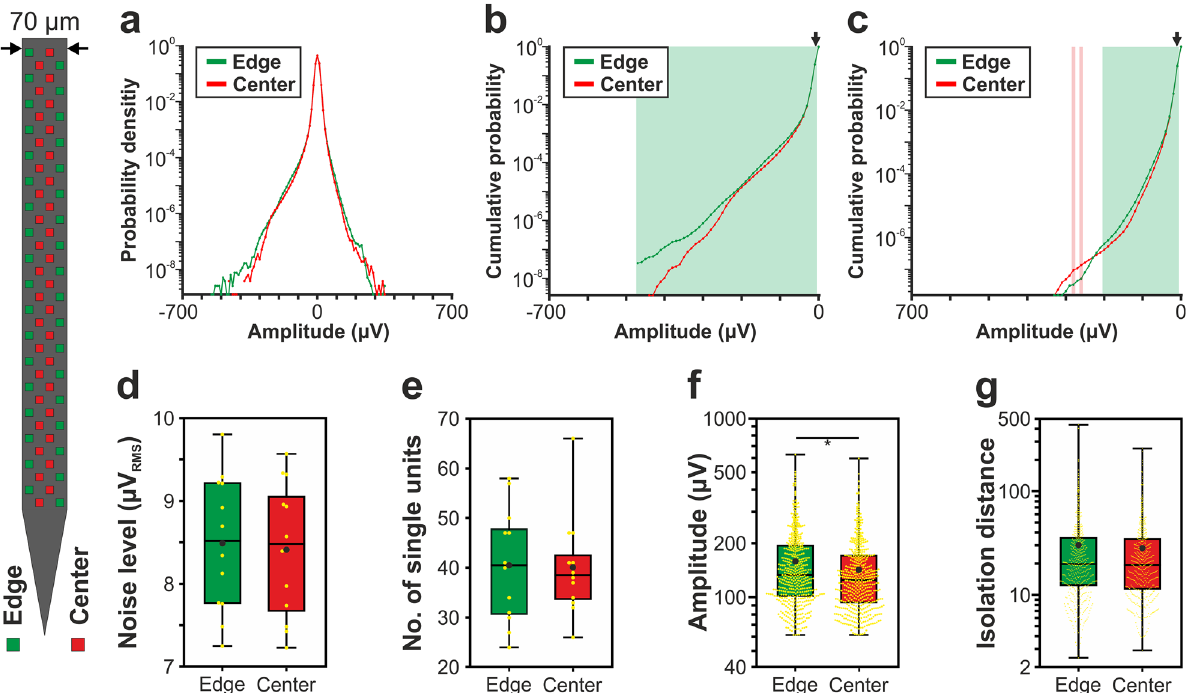
Figure 4. Comparison of the signal quality provided by edge (green) and center (red) sites of the 70-μm-wide Neuropixels silicon probe. ( a ) Probability density functions estimated from the amplitude of samples recorded in the 500–5000 Hz frequency range (n = 6 recordings). Probability values lower than 10 –9 are not shown. ( b ) Cumulative distributions of amplitudes calculated in the negative amplitude range. ( c ) Reverse cumulative distributions calculated in the positive amplitude range. Green (or red) shaded areas in ( b ) and ( c ) indicate amplitudes with significantly higher numbers of edge (or center) samples. Arrows mark the maximal amplitude for edge significance in the negative range (− 10 µV; below this amplitude 12.20% of all negative samples were recorded on edge sites and 12.14% on center sites) and the minimal amplitude in the positive range (10 µV; above this amplitude 12.21% of all positive samples were recorded on edge sites and 12.15% on center sites). ( d ) Estimated in vivo noise level. ( e ) Single unit yield (n = 967). ( f ) Peak-to-peak amplitude of the averaged single unit spike waveforms. ( g ) Isolation distance of the single unit clusters. Note that most data are plotted on